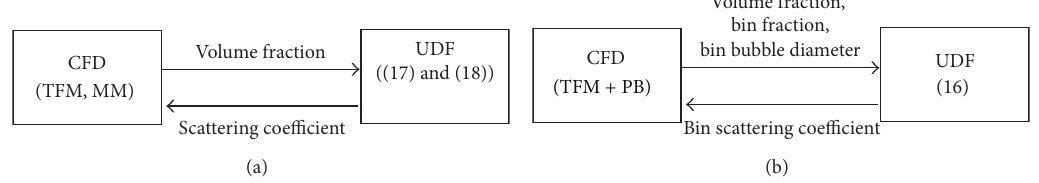
Figure 2: Flow diagram depicting the exchange of variables between the CFD calculations and the user-defined functions (UDFs) for computing the scattering coefficients.